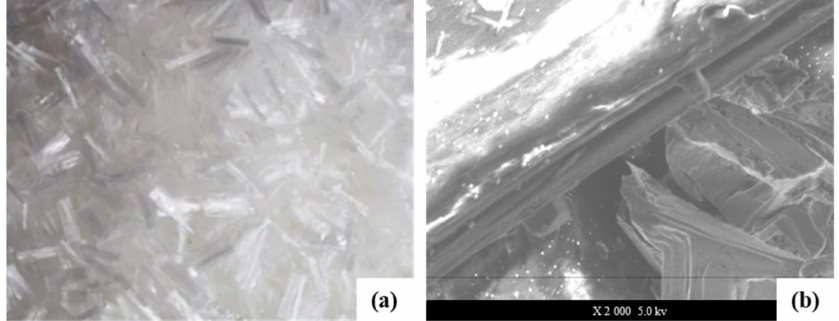
Figure 4. Polypropylene fiber ( a ), microstructure of polypropylene ( b ).